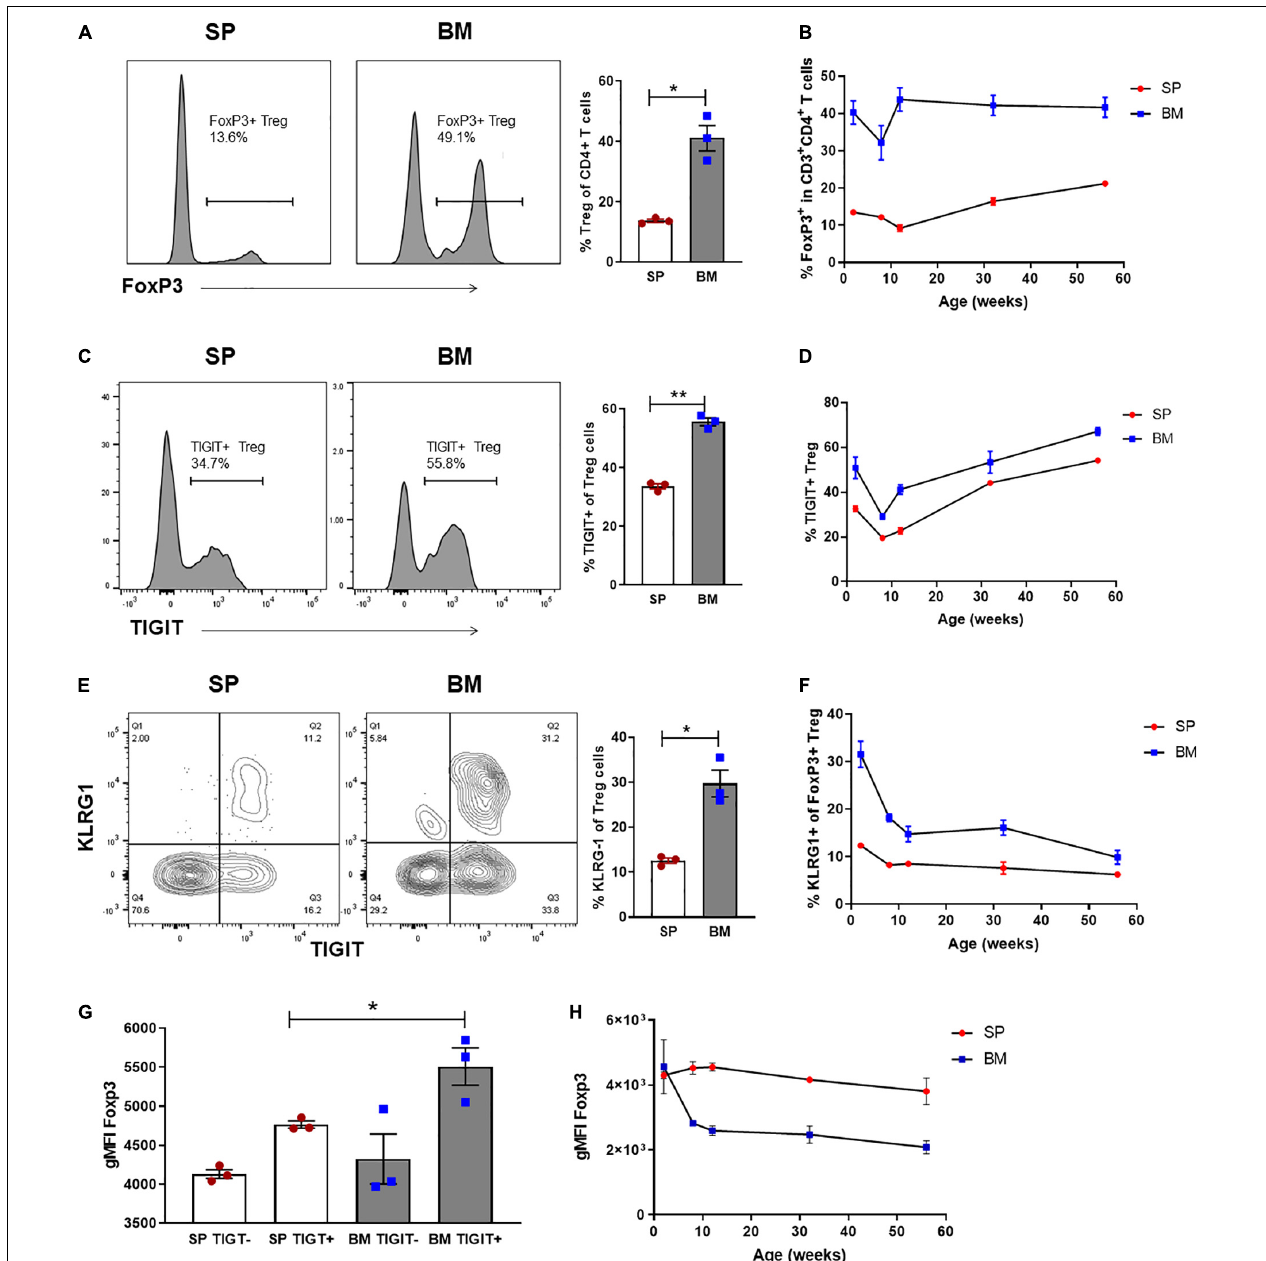
FIGURE 5 | BM-Treg represent a heterogenous and phenotypically distinct population from an early age. Flow cytometry analysis CD4 + T cells isolated from naïve C57BL/6 mice aged 2–52 weeks ( n = 3). (A) Representative histogram and frequency (%) of FoxP3 + expression in the SP and BM of 2-week-old mice. (B) Frequency (%) of FoxP3 + Treg in the SP and BM of aging mice from 2 to 52 weeks. (C) Representative histogram and% of TIGIT + expression in 2-week-old mice (D) Frequency (%) of TIGIT + Treg in the SP and BM of aging mice. (E) Representative histogram and frequency (%) of KLRG1 + expression in 2-week-old mice. (F) Frequency (%) of KLRG + Treg in the SP and BM of aging mice. (G) gMFI of intracellular FoxP3 expression in TIGIT neg and TIGIT + CD4 + CD3 + T cells isolated from the SP or BM of 2-week-old mice. (H) gMFI of intracellular FoxP3 expression in the SP and BM of aging mice. Data are shown as mean ± SEM, and statistical significance was determined using paired t test (* P < 0.05; ** P < 0.01). Statistical analyses were performed using GraphPad Prism version 6.01